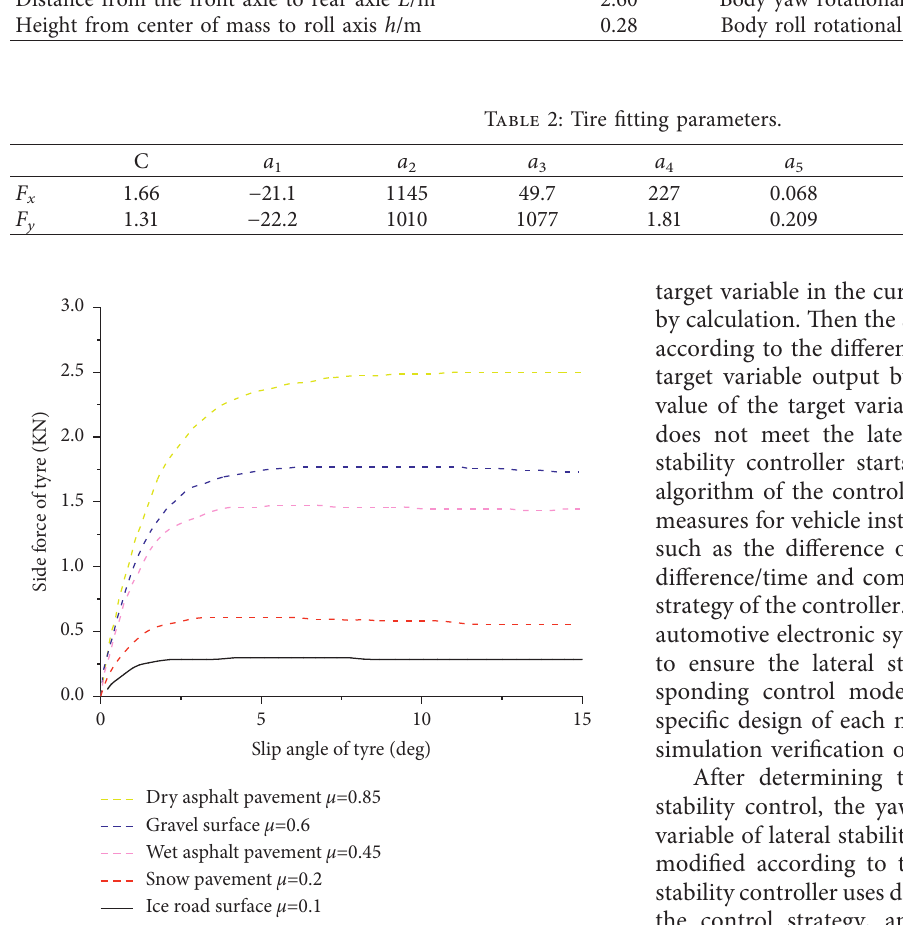
Figure 2: Tire cornering characteristics under different adhesion